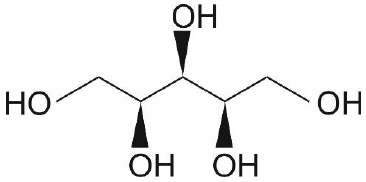
Figure 1. Chemical structure of xylitol © DuPont Nutrition & Biosciences.